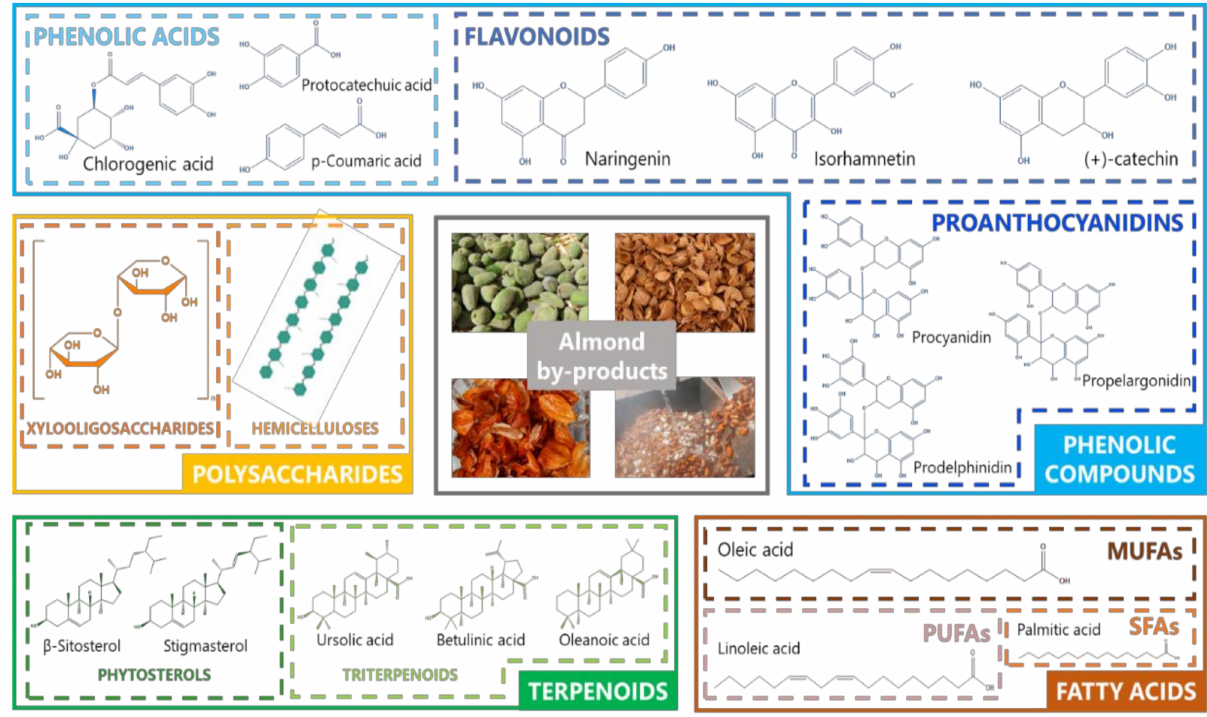
Figure 2. Most representative bioactive compounds found in almond by-products. Phenolic compounds in almond by-products are mainly described by the presence of phenolic acids, flavonoids, anthocyanins, and lignin, among others. In the case of